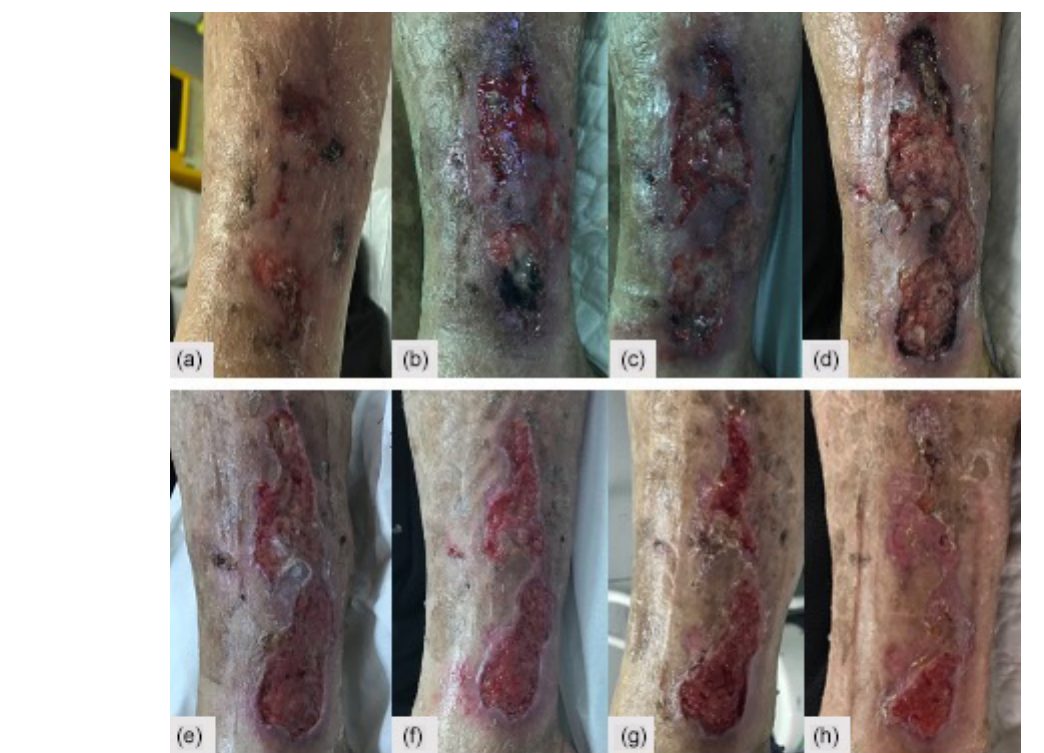
Figure 5. (a–d) Lateral leg wound evolution and (e–h) response after institution of a 2-week course of oral amoxicillin–clavulanate.